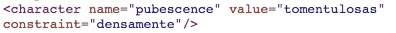
Structured text that exemplifies the use of adverbs in the chunk T3L9S5.